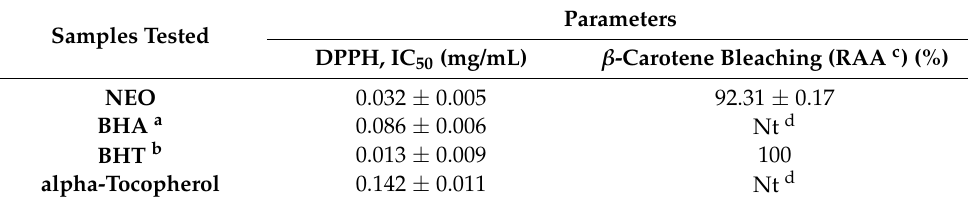
Table 2. Antioxidant activities of the NEO by 1,1-diphenyl-2-picrylhydrazyl (DPPH) and β -carotene bleaching assay.